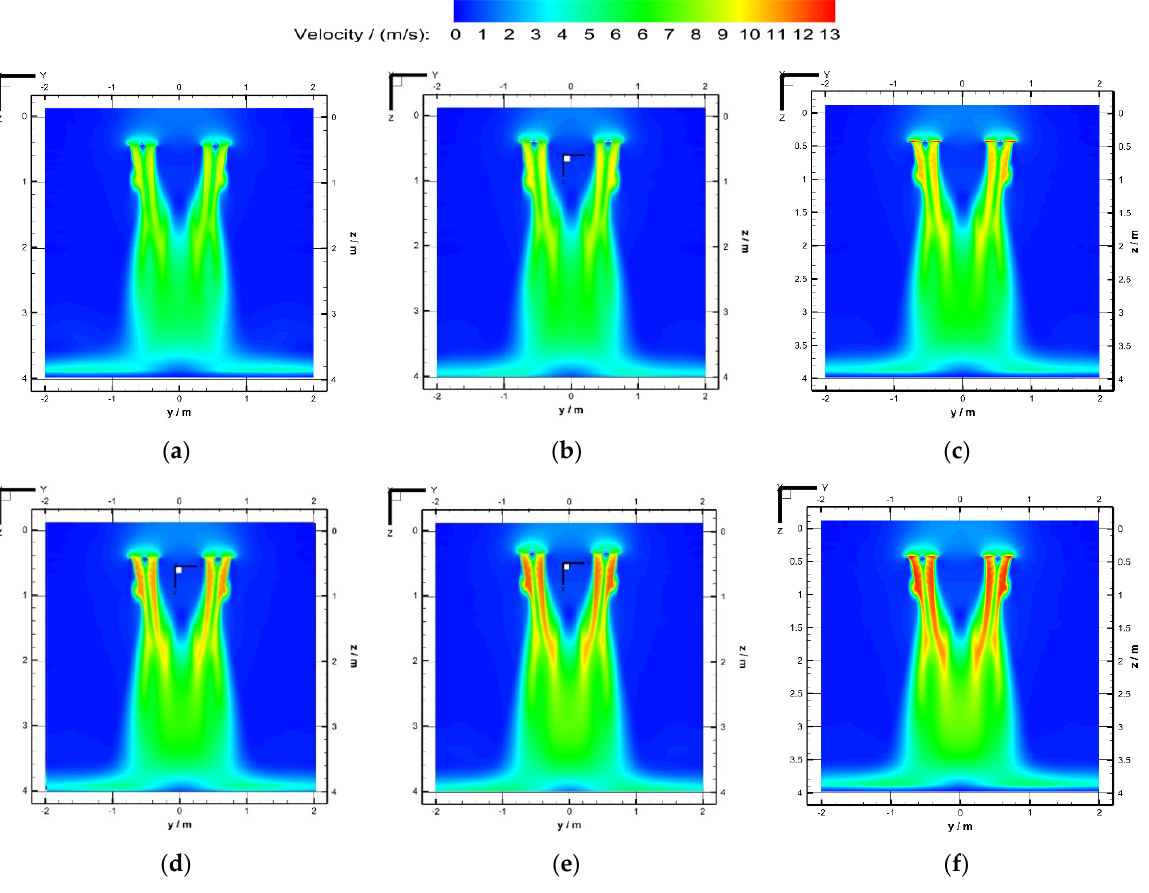
Figure 5. Velocity distribution of the ZOY planes of different pesticide load: ( a ) 0 kg; ( b ) 1 kg; ( c ) 2 kg; ( d ) 3 kg; ( e ) 4 kg; ( f ) 5 kg.